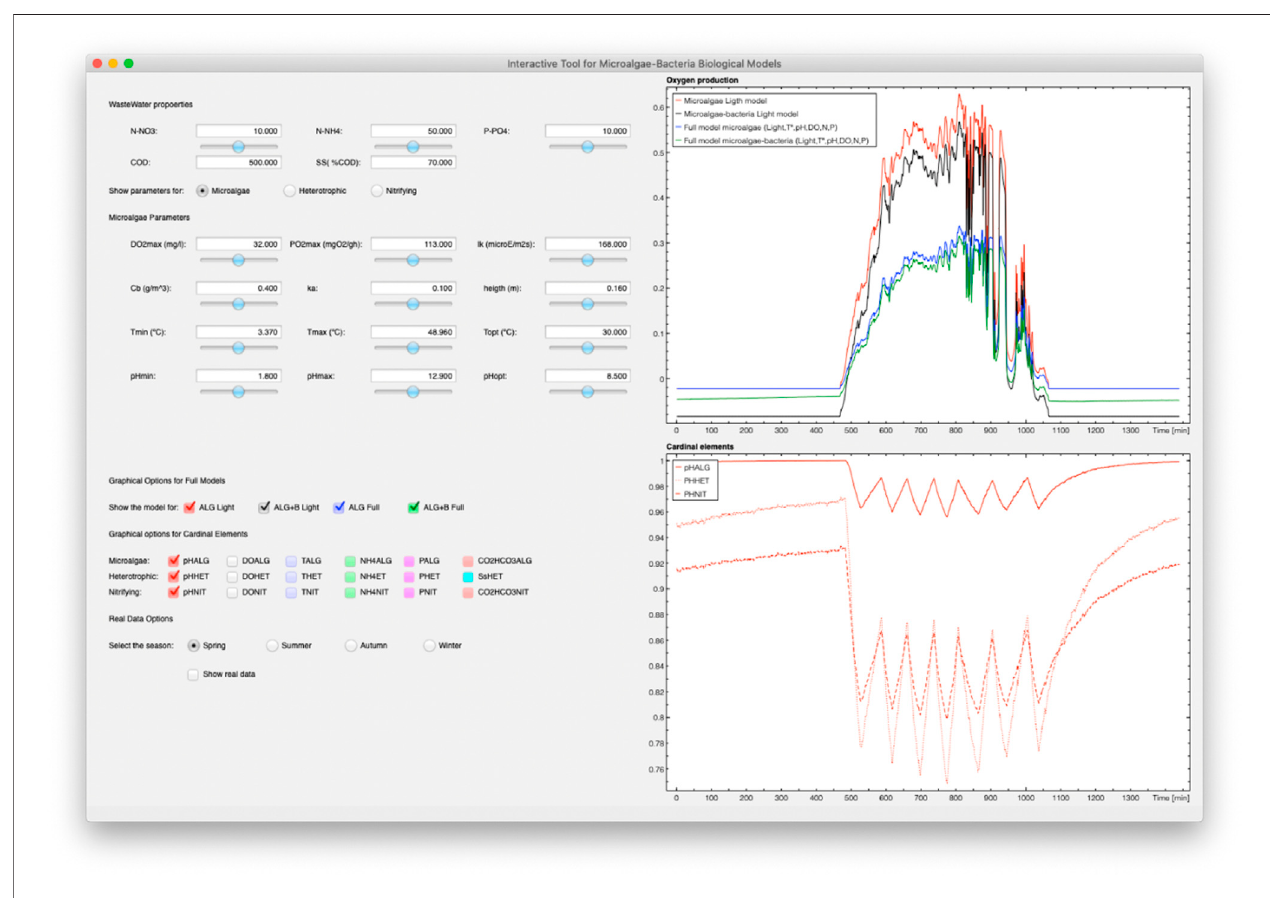
FIGURE 4 | Main screen of the interactive